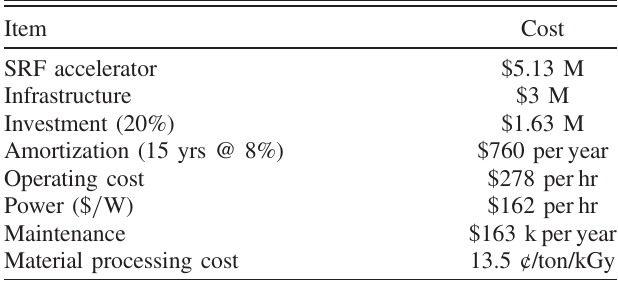
TABLE IX. Capital investment and estimated cost of operating the 1 MW, 10 MeV SRF